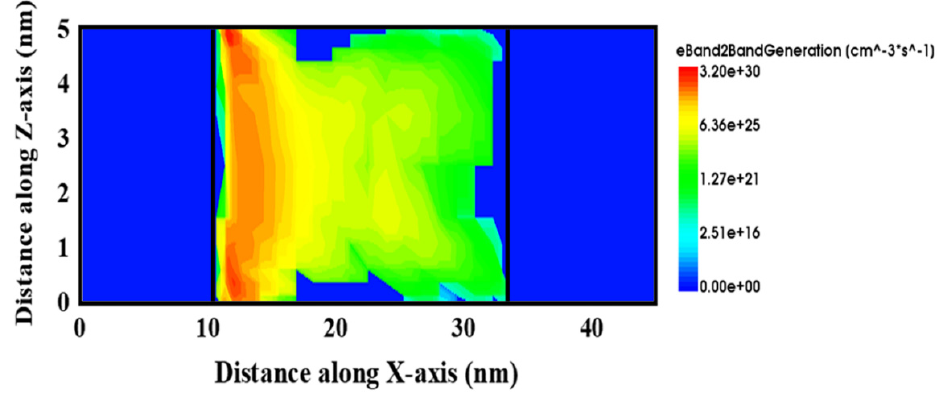
Figure 8. The electron band-to-band generation rate of Fe-ED NSTFET.